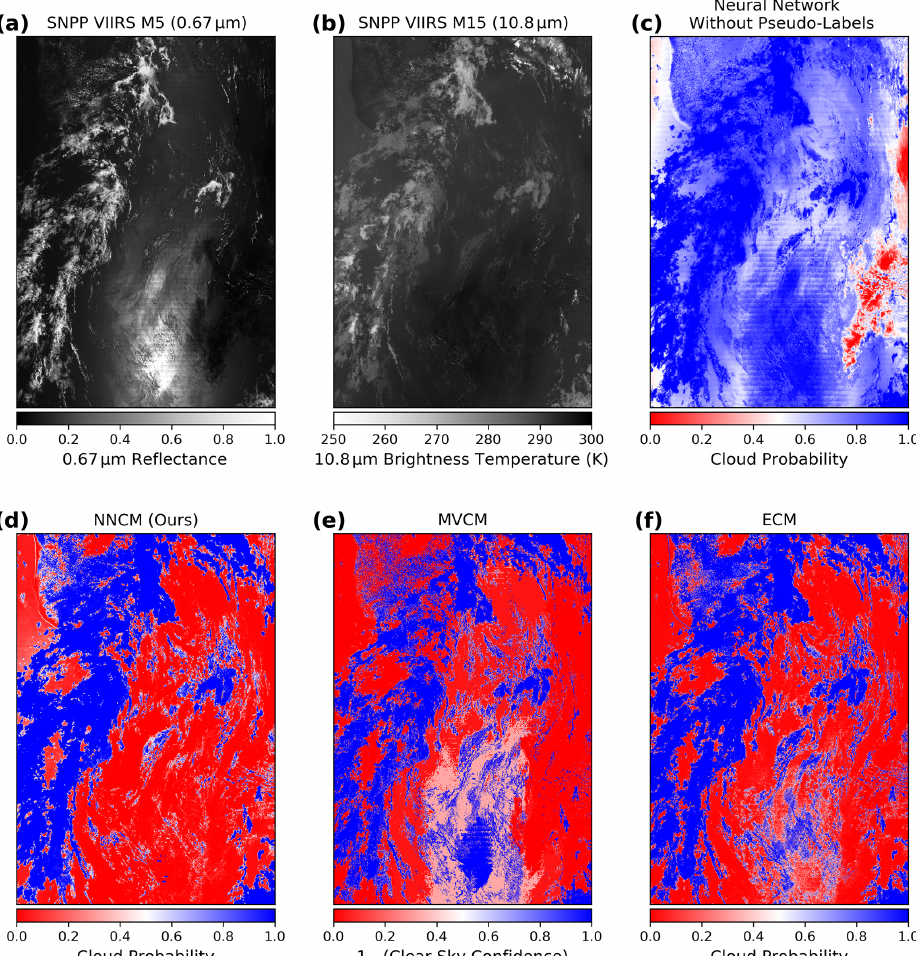
Figure 2. Comparison of the neural network cloud mask without pseudo-labels (c) , the NNCM (d) , the MVCM (e) , and the ECM (f) . Also shown are band M5 with a central wavelength of roughly 0.67µm (a) and band M15 with a central wavelength of roughly 10.8µm (b)